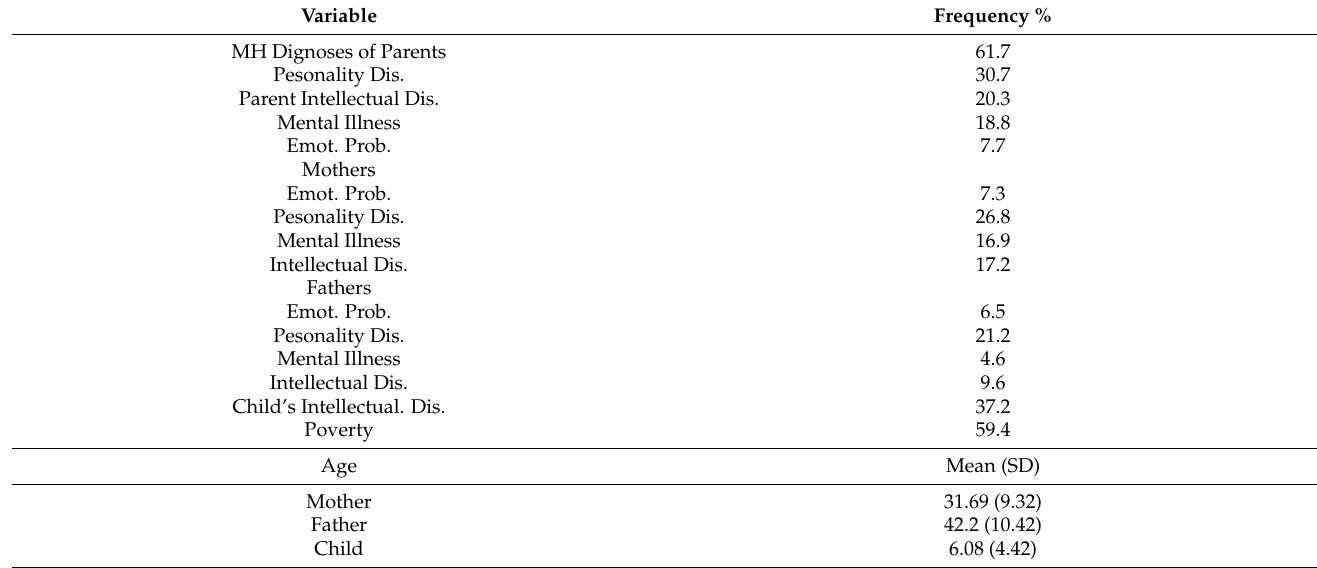
Table 1. Family Characteristics of Study’s